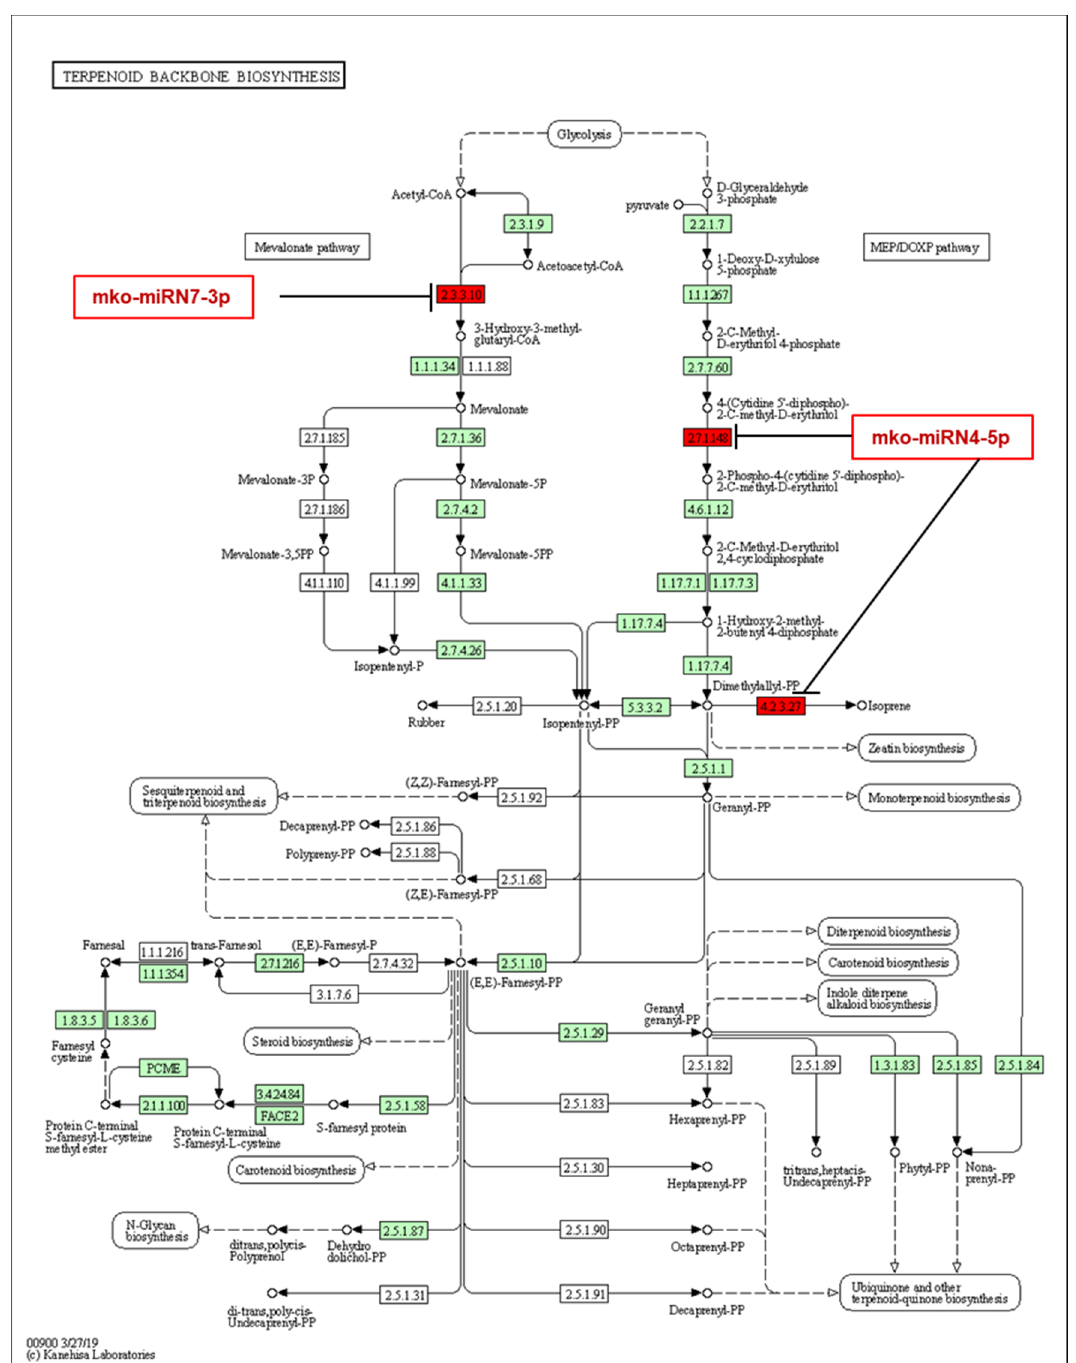
Figure 8. Target enzymes of the novel miRNAs of M. koenigii in the terpenoid backbone biosynthesis pathway. EC:4.2.3.27—isoprene synthase; EC:2.7.1.148—4-diphosphocytidyl-2-C-methyl-D-erythritol kinase; EC:2.3.3.10—hy- droxymethylglutaryl-CoA synthase. The red boxes represent the targeted enzymes of the corresponding novel miRNAs.